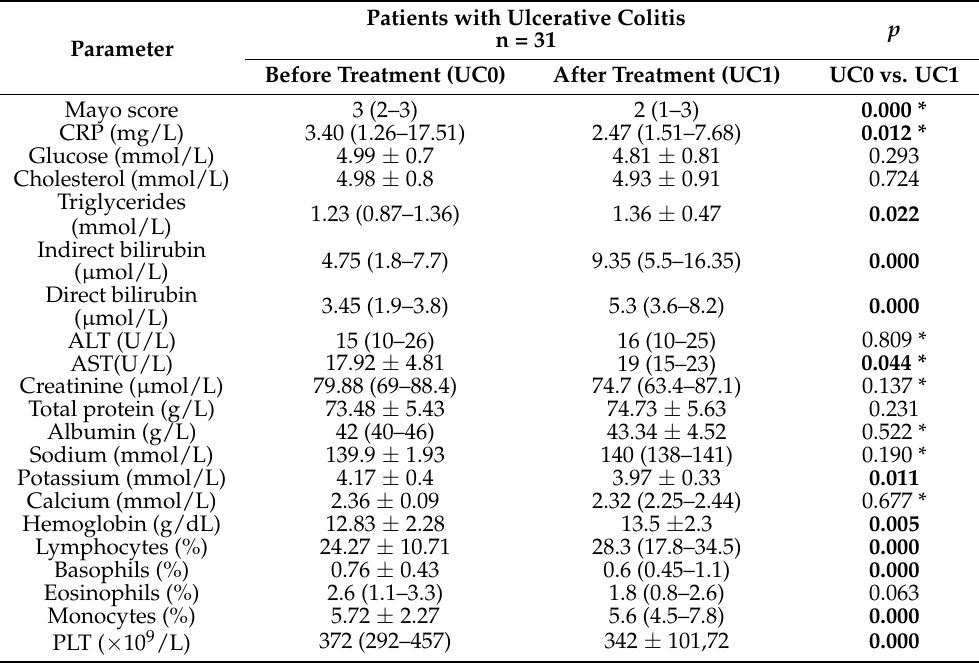
Table 1. Clinical characteristic of patients with ulcerative colitis (UC) before and after a year of treatment with Adalimumab.